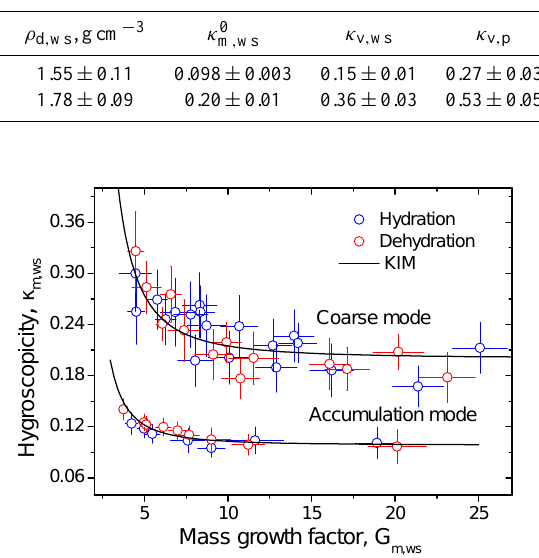
Figure 9. Mass-based hygroscopicity parameter κ m , ws as a function of mass growth factor, G m , ws , normalized to water-soluble com- pounds (Eq. 12) upon hydration (blue) and dehydration (red). KIM fit of dilution mode, Eq. (8) – black solid